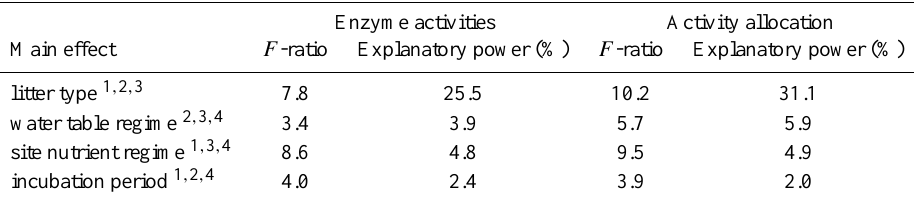
Table 3. Variation partitioning using redundancy analysis (RDA) showing percentage of the total variation in enzyme activities and activity allocation explained by litter type, nutrient and water table regime and litter decomposition stage (incubation period). To analyse the overall pattern rather than the direct effects (see hypotheses), all litter types (common and specific, see Table 1) were included in the analysis. All effects were significant at p < 0 . 002.